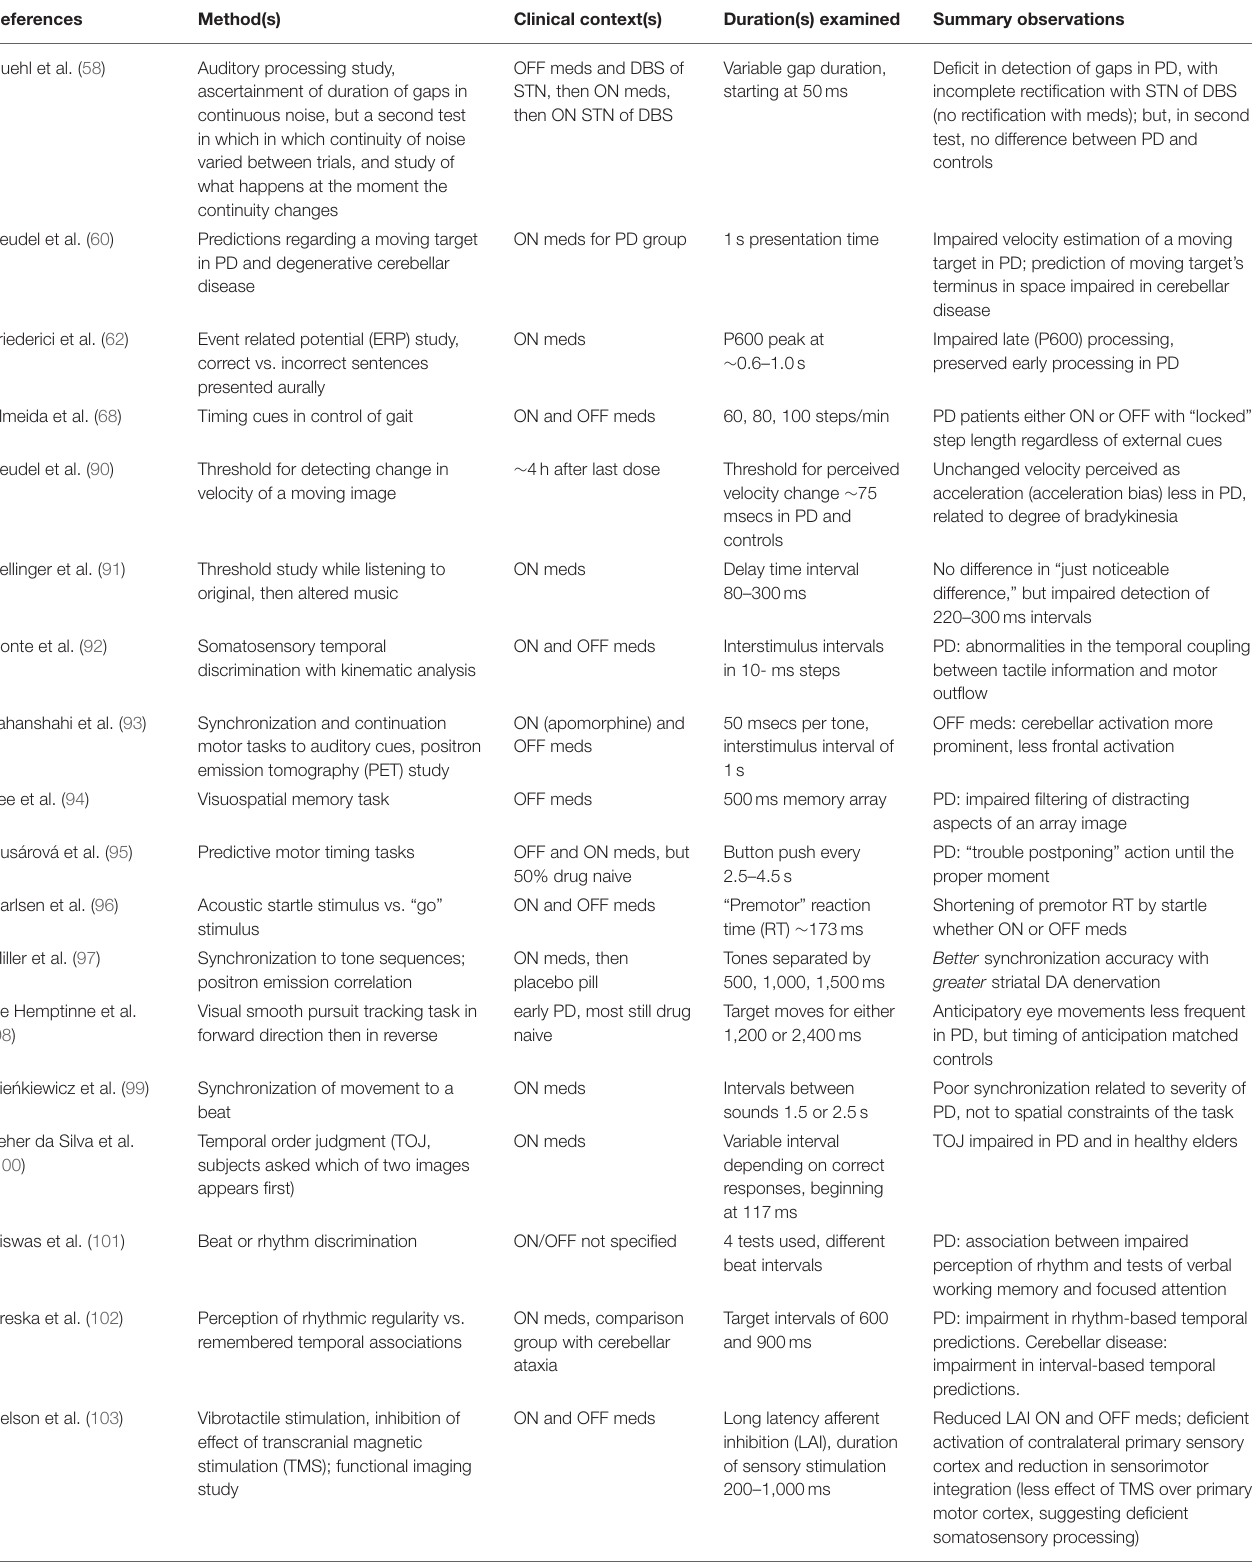
TABLE 1 | Representative implicit timing studies regarding altered somatomotor processing (all vs. controls, with other intergroup analyses, as